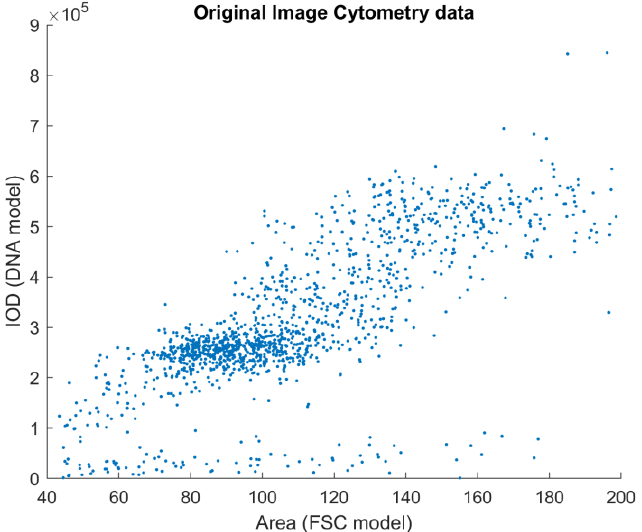
Figure 4. Image cytometry data on a DNA content–object area scatterplot. Each data point represents a cell nucleus. The unit of both axes are intensity-based: on the y -axis is the integrated optical density—the proposed model for the DNA content; on the x -axis is the object area, measured after segmenting the nuclei from the image. Some subpopulations are identifiable, but not as clearly as on the FCM plot.